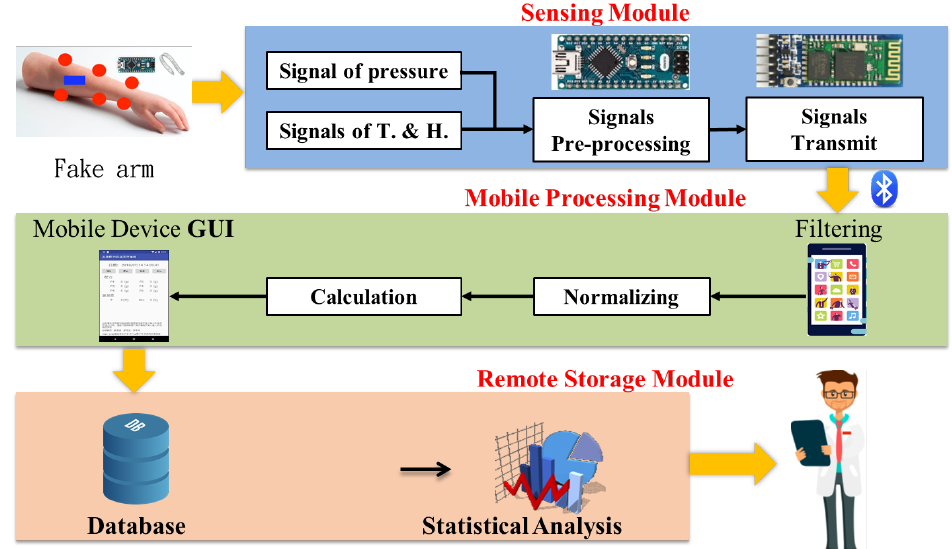
Figure 1. Real-time monitoring of pressure, temperature, and humidity in the cast system architecture.